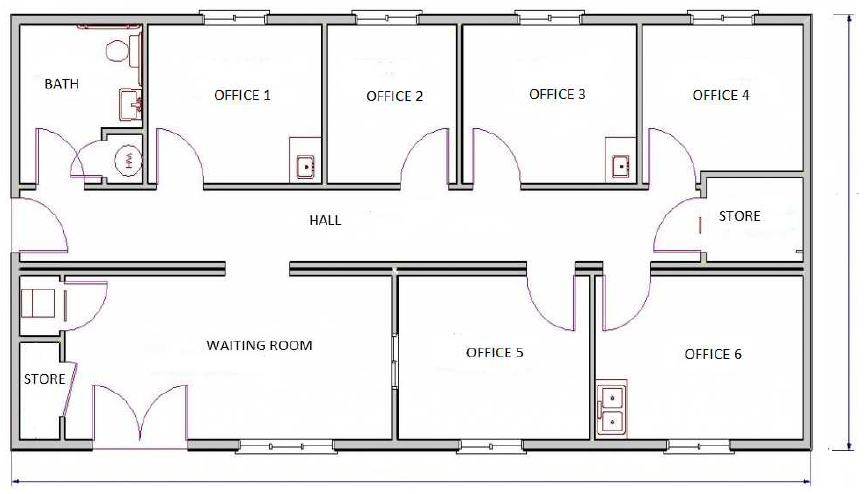
Figure 5. Layout of the selected commercial building.